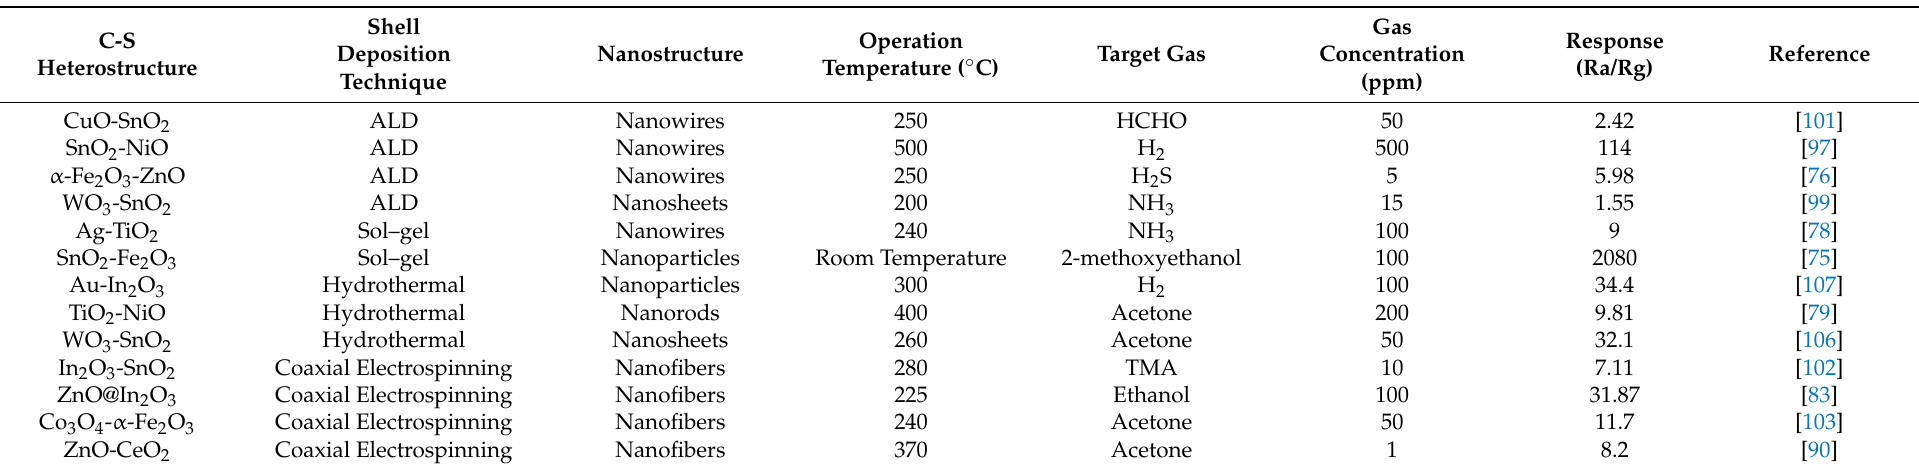
Table 3. Summary of some MOS C-S nanostructure